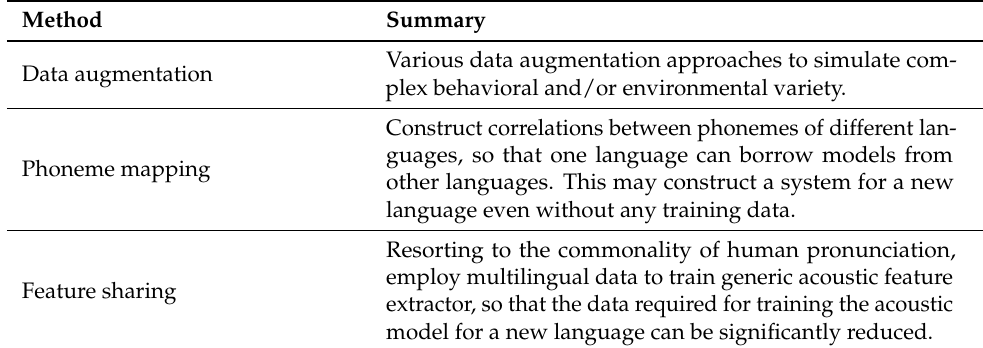
Table 1. Representative methods of low-resource